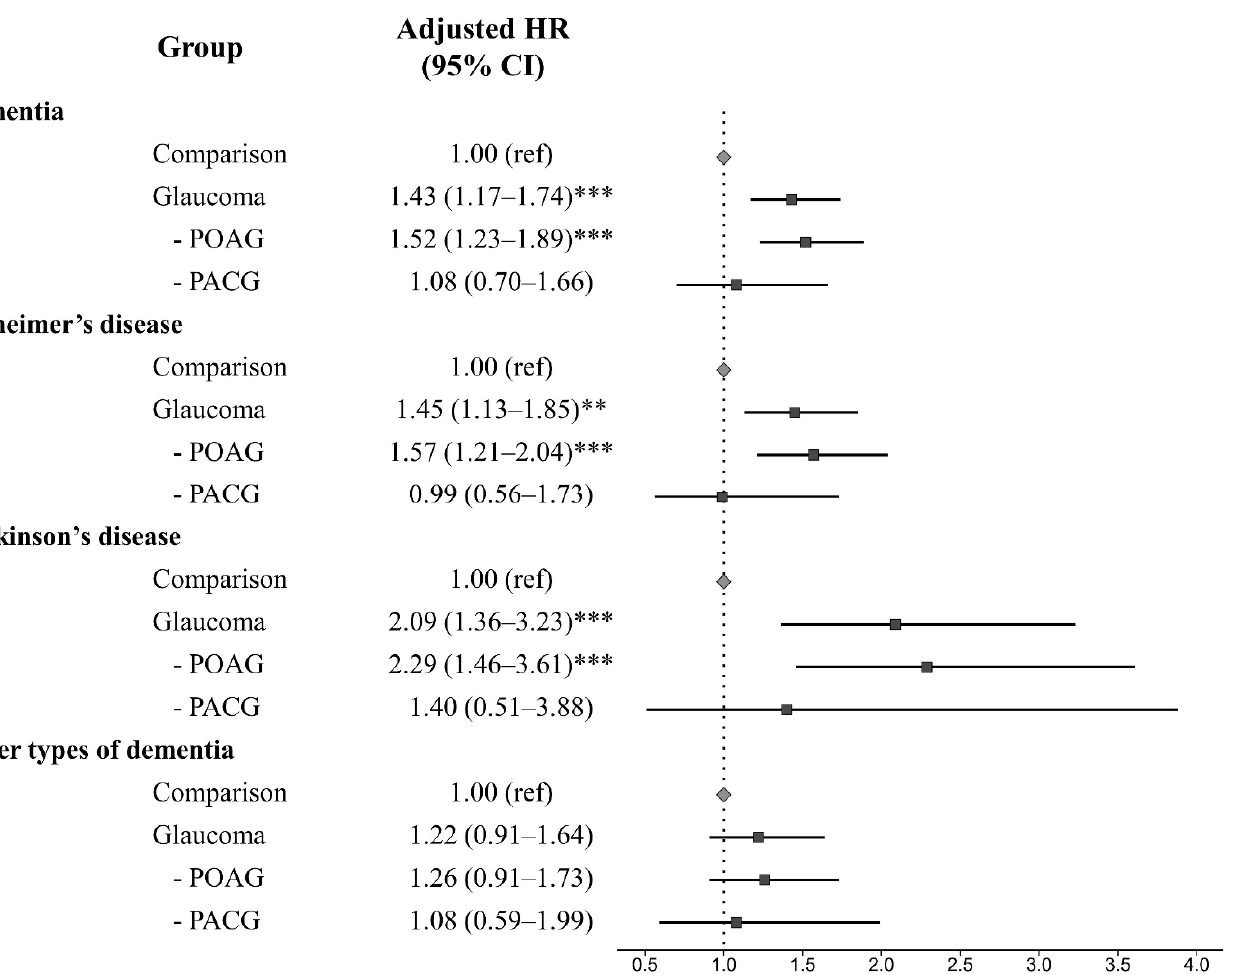
Figure 2. The adjusted hazard ratio plot of each dementia subtype among groups. POAG, primary open-angle glaucoma; PACG, primary angle-closure glaucoma; HR, hazard ratio; CI, confidence interval. ** p < 0.010 and *** p < 0.001.